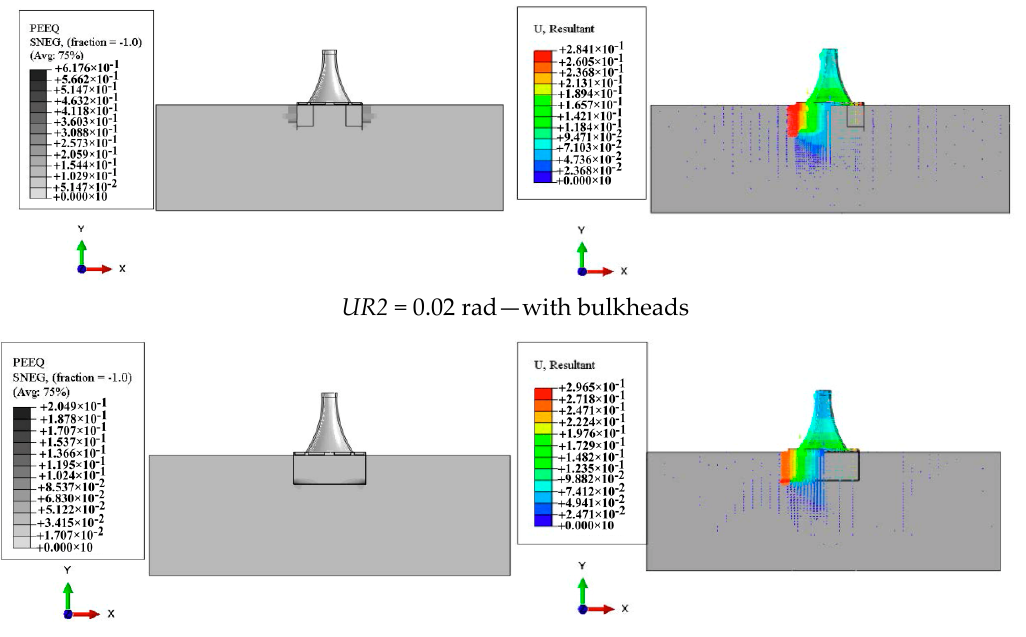
Figure 17. Vector diagram of soil deformation and displacement.